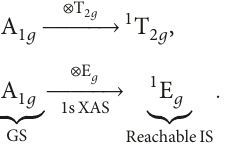
1 g ≈ 7eV . < − 5 eV and E T T